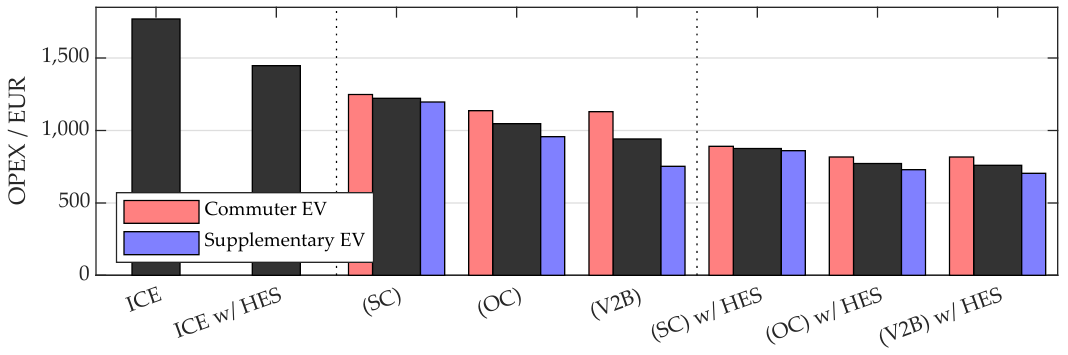
Figure 5. Operating expenses (OPEX) for one year. The dark-grey column represents the average